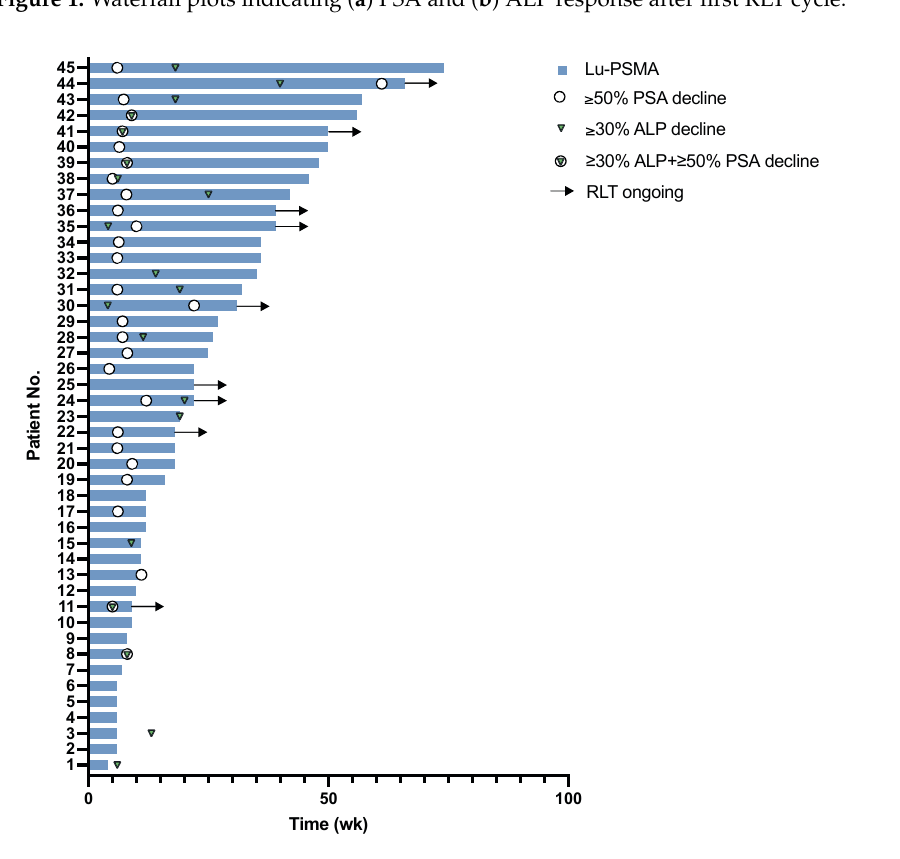
Figure 3. Maximum intensity projections of 68 Ga-PSMA-11 PET/CT imaging in a 69-year-old patient at the baseline ( a ), upon interim staging ( b ), with excellent treatment response after 6 cycles of 177 Lu-PSMA-617 after 46.3 GBq of cumulative treatment activity ( c ).